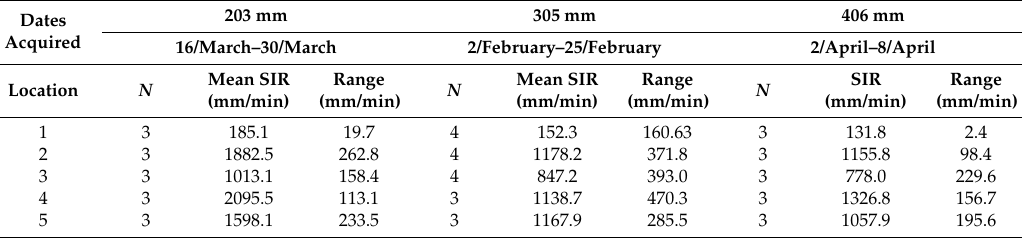
Table 2. SIR data collected on the Porous Pave surface in the spring of 2016 using the ASTM C1701 standard test with the three ring sizes. Sample size N (of the data leading to the mean SIR and range given) is provided for each location tested on the surface. The dates encompassing the period of collection are shown as day/month. Means are given instead of the median as the latter cannot be computed with less than 3